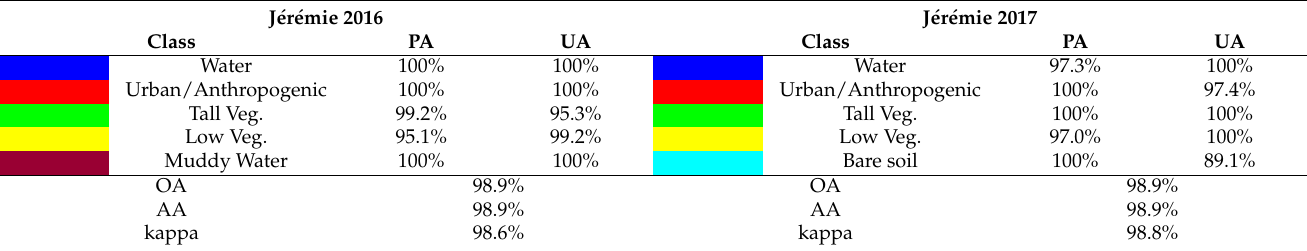
Table 1. Accuracy scores for the two classification maps obtained with the datasets “J é r é mie 2016” and “J é r é mie 2017”. The corresponding maps are shown in Figure 7a,b. Legend: OA = overall accuracy, AA = average accuracy, PA = producer accuracy, UA = user accuracy, kappa = Cohen’s κ statistic.